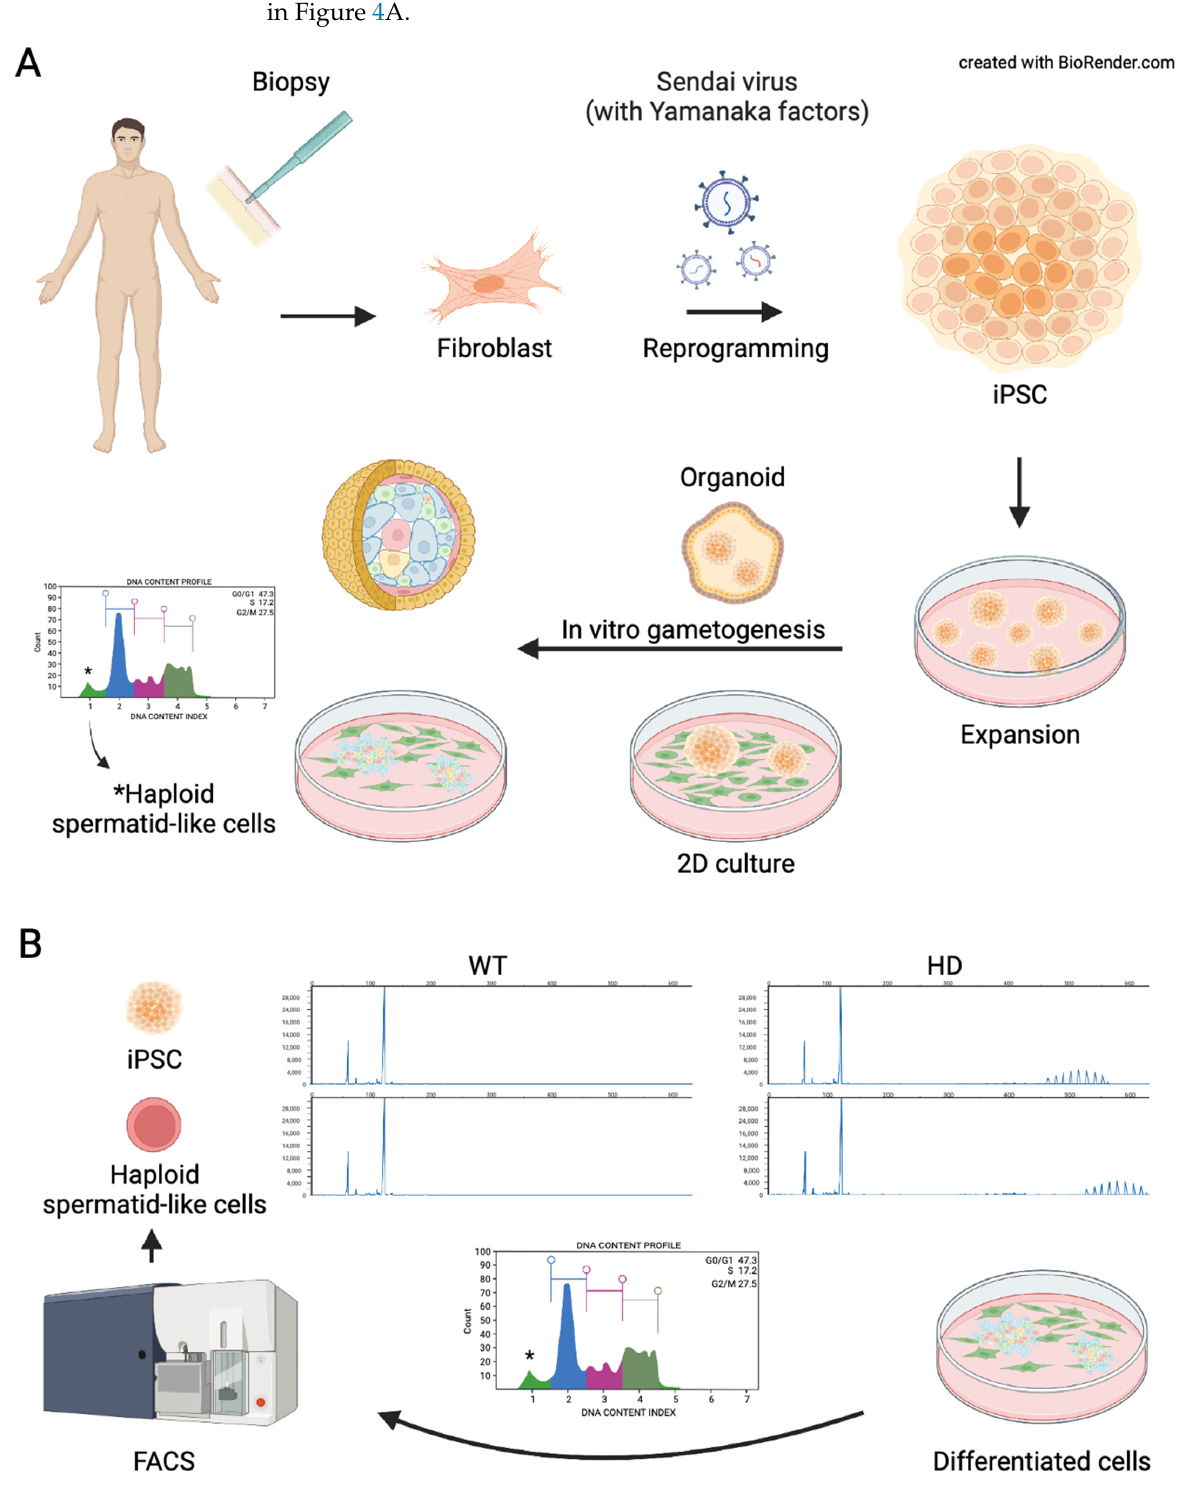
Figure 4. Schematic representation of current models of in vitro spermatogenesis. ( A ) somatic cells can be collected from a patient where they can be reprogramed with reprogramming factors to de- rive induced pluripotent stem cells (iPSCs). The iPSCs can be preserved, expanded, and induced to produce advanced spermatogenic cells via 2D culture methods or 3D culture methods (3D). ( B ) A